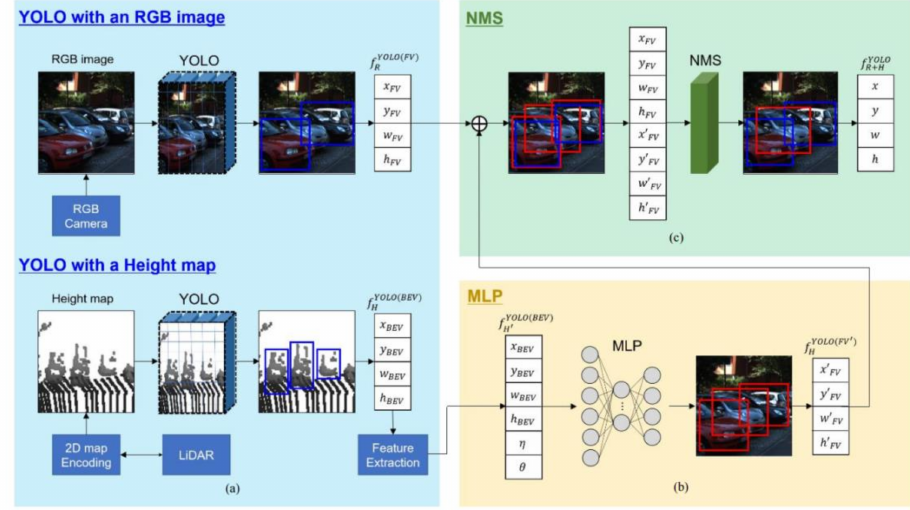
Figure 3. Architecture of proposed object detection system: ( a ) detect objects in parallel structure comprising a set of single YOLO modalities, ( b ) convert bounding boxes to the same viewpoint using MLP, and ( c ) converge detection results based on